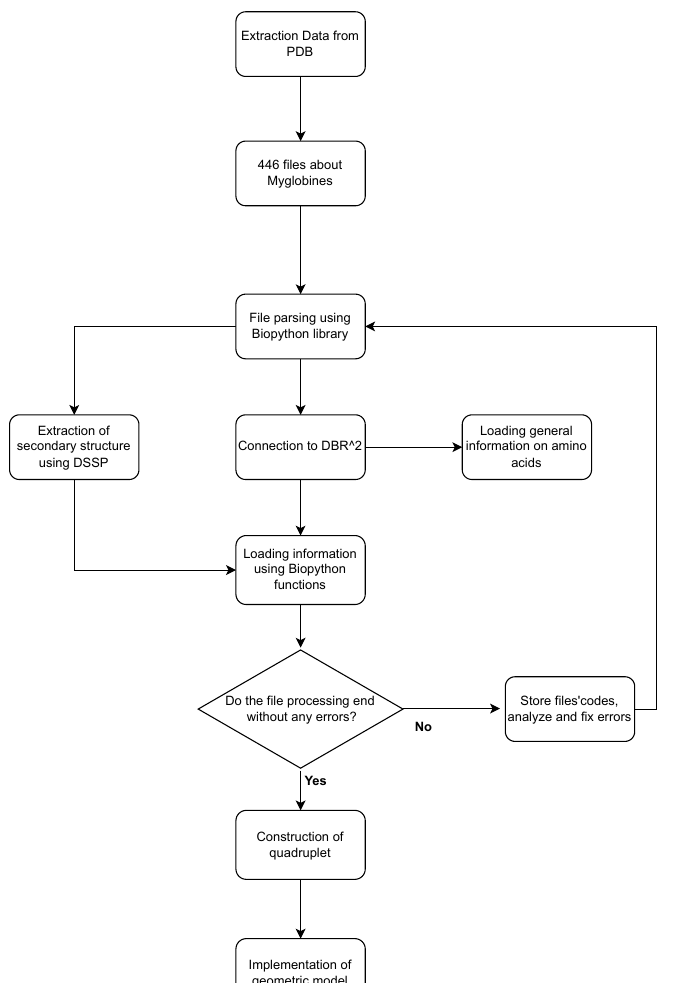
Figure 5. Illustrative schema of the DBR 2 population